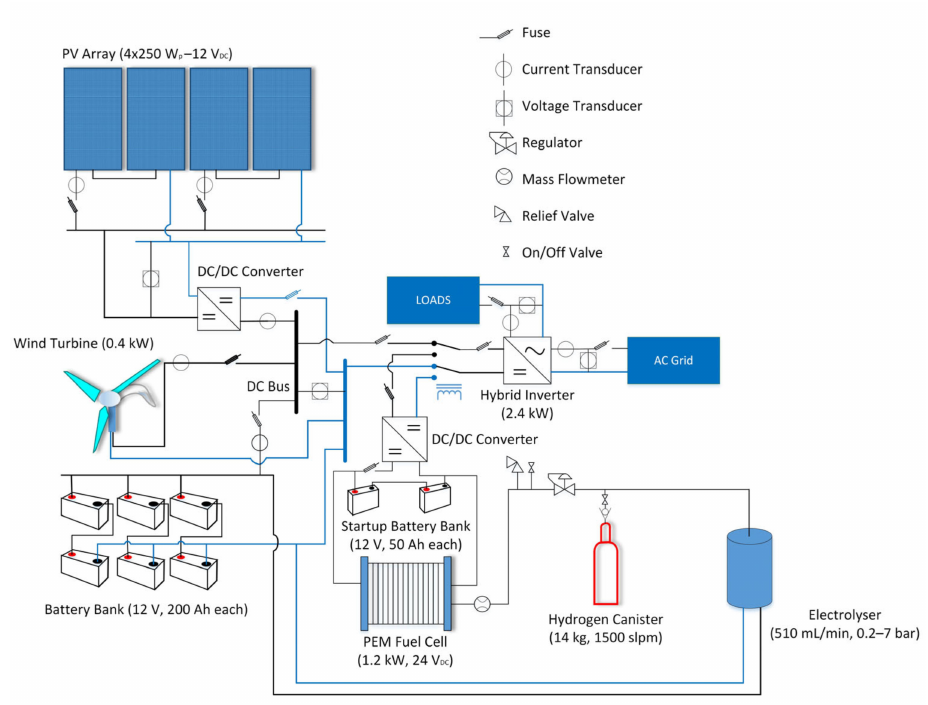
Figure 1. Overall system